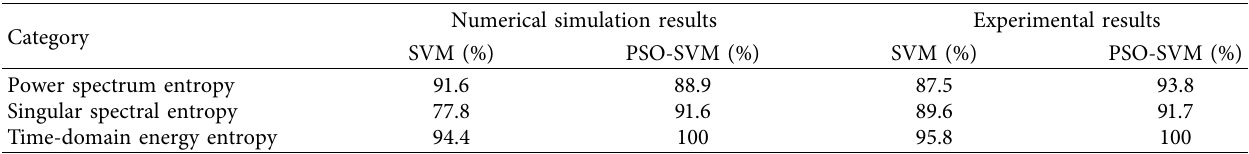
Table 3: Results’ comparison